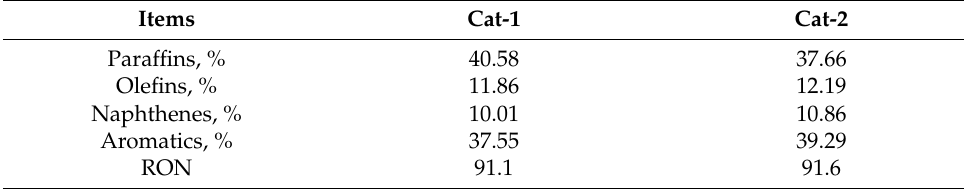
Table 4. PONA analysis and octane number of cracked